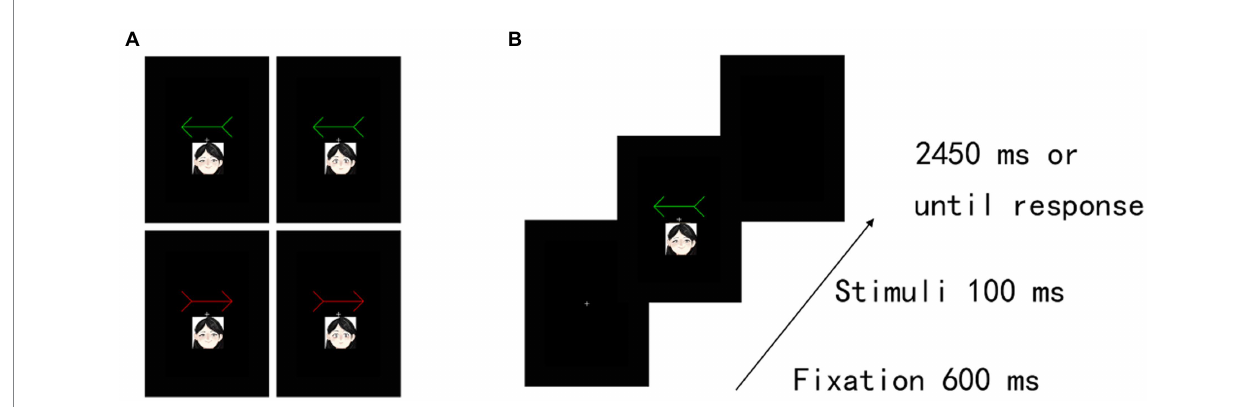
FIGURE 3 Experimental task structure and results in Experiment 2A. (A) Examples of happy-and neutral-arrow pair stimuli. (B) Illustration of stimuli presentation in the training task. Two different colour arrows (i.e., red and green) were included. These arrows were associated with a happy face or a neutral face in the training task. The actual stimuli were photographs of emotional faces from the KDEF database of faces (see Lundqvist et al., 1998).